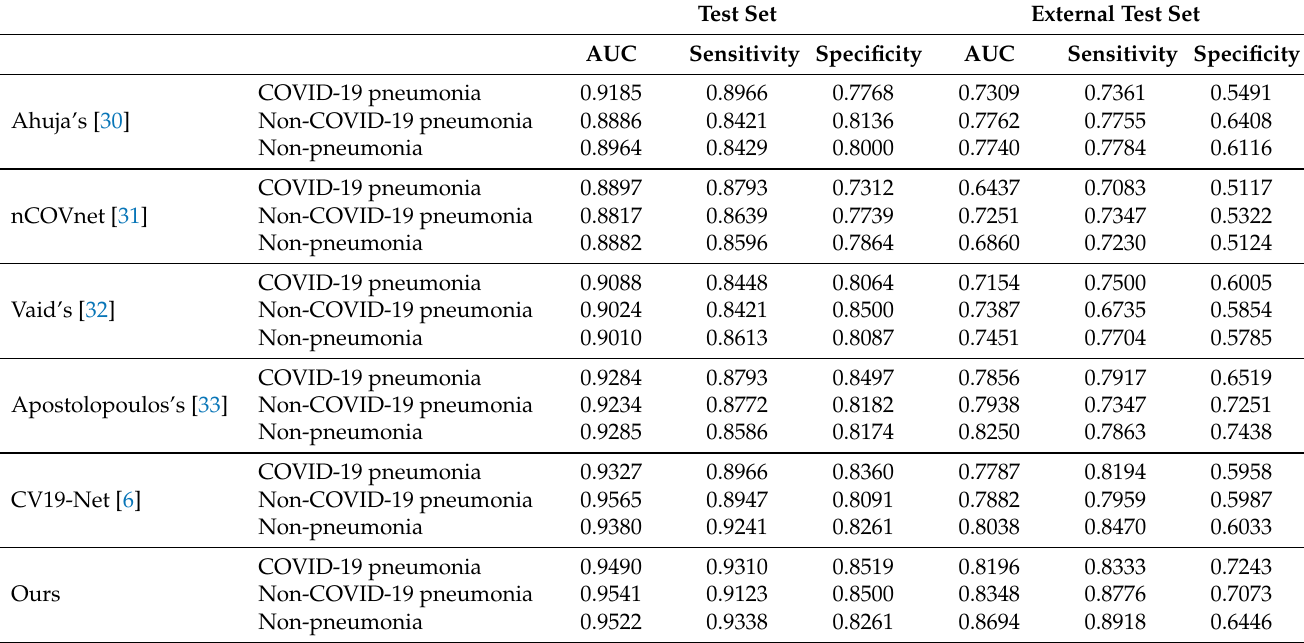
Table 3. Performance comparison for each class on the test set and the external test set in terms of AUC scores, Sensitivity, and Specificity.